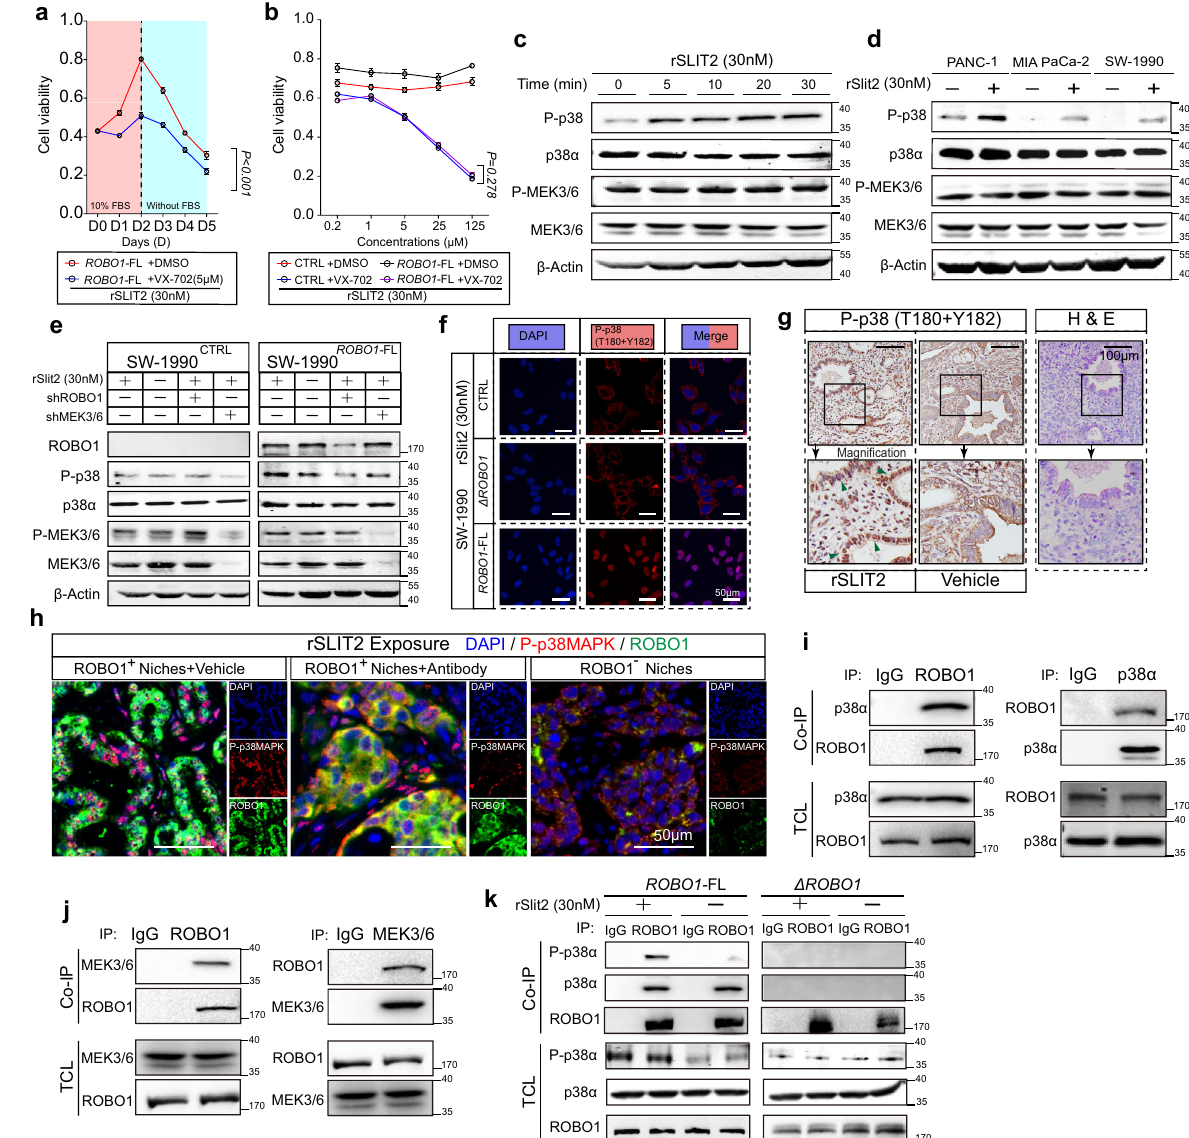
Fig. 7 | The SLIT2-ROBO1 axis triggers p38 α MAPK. a Viability of SW-1990 ROBO1 -FL cellsexposedto30nMrSLIT2withorwithoutthep38 α MAPK-speci fi cinhibitorVX- 702 (5 μ M) ( n =2 biological replicates, mean±SEM., one-way repeated-measures ANOVA).TheY-axisrepresentsODvaluesat450nm. b Viabilityof SW-1990 CTRL and SW-1990 ROBO1 -FL cells treated with 30nM rSLIT2 with or without the p38 α MAPK- speci fi c inhibitor VX-702 at various concentrations (0.2 μ M, 1 μ M, 5 μ M, 25 μ M, 125 μ M; time point=D3; n =2 biological replicates; mean±SEM.; one-way Repeat- Measure ANOVA). ns. no signi fi cant difference, P > 0.05 . The Y-axis represents OD values at 450nm. c WB displaying the time-dependent rSLIT2-induced p38 α MAPK phosphorylation in SW-1990 Robo1 -FL cells ( n =2 biological replicates). d WB showing the phosphorylation of p38 α MAPK in PANC-1, MIA PaCa-2 or SW-1990 cell lines treated with 30nM rSLIT2 ( n =2 biological replicates). e WB displaying the rela- tionshipof SLIT2(30nM),ROBO1and MEK3/6expression with phosphorylation of MEK3/6orp38 α MAPK ( n =2 biological replicates). f Representative ICC staining in 30nM rSLIT2-treated SW-1990 CTRL , SW-1990 Δ ROBO1 and SW-1990 ROBO1 -FL cells